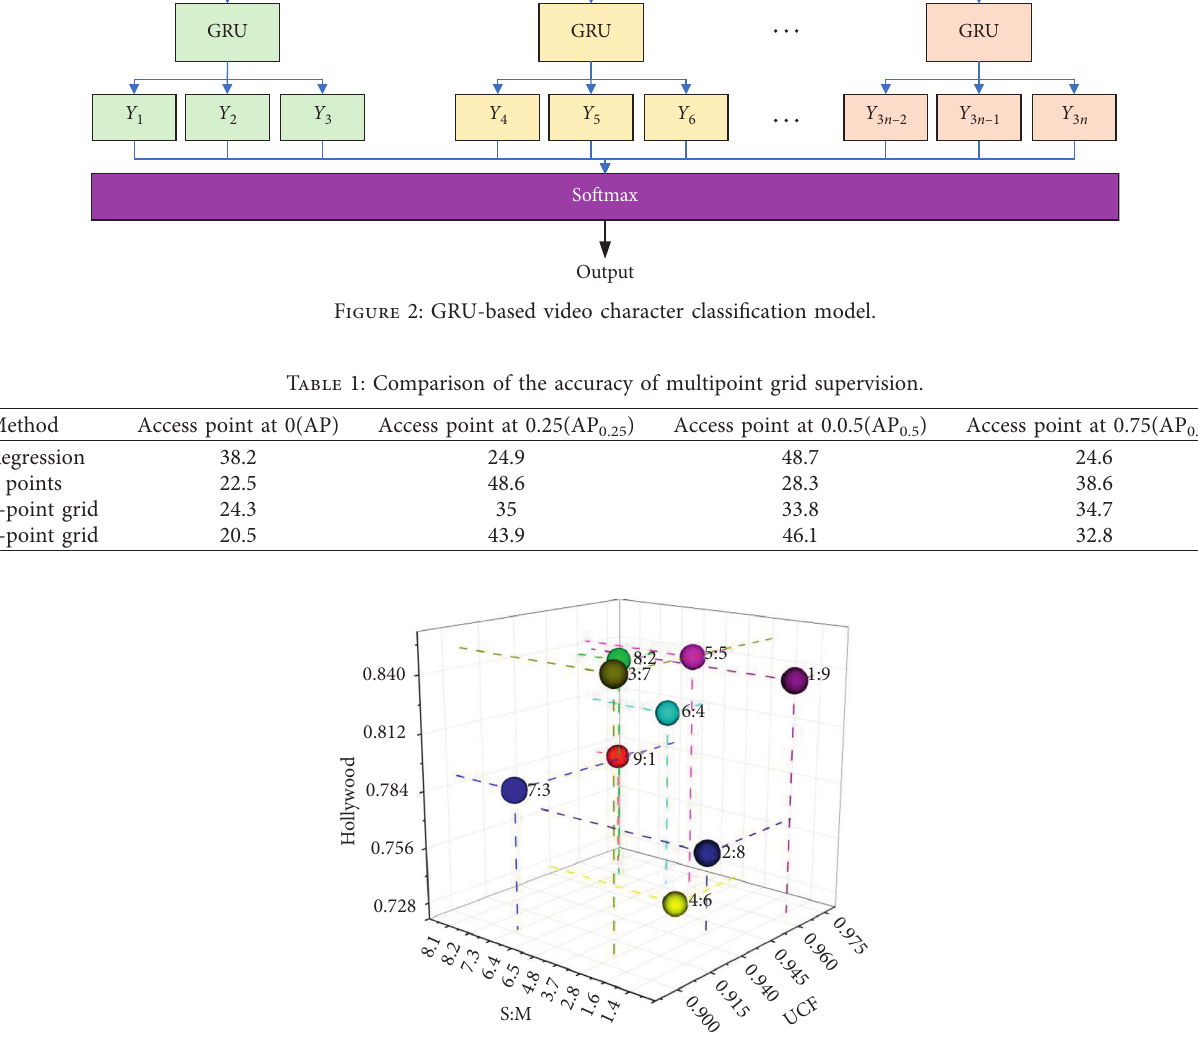
Figure 3: Results of different dynamic and static feature contribution ratios in two